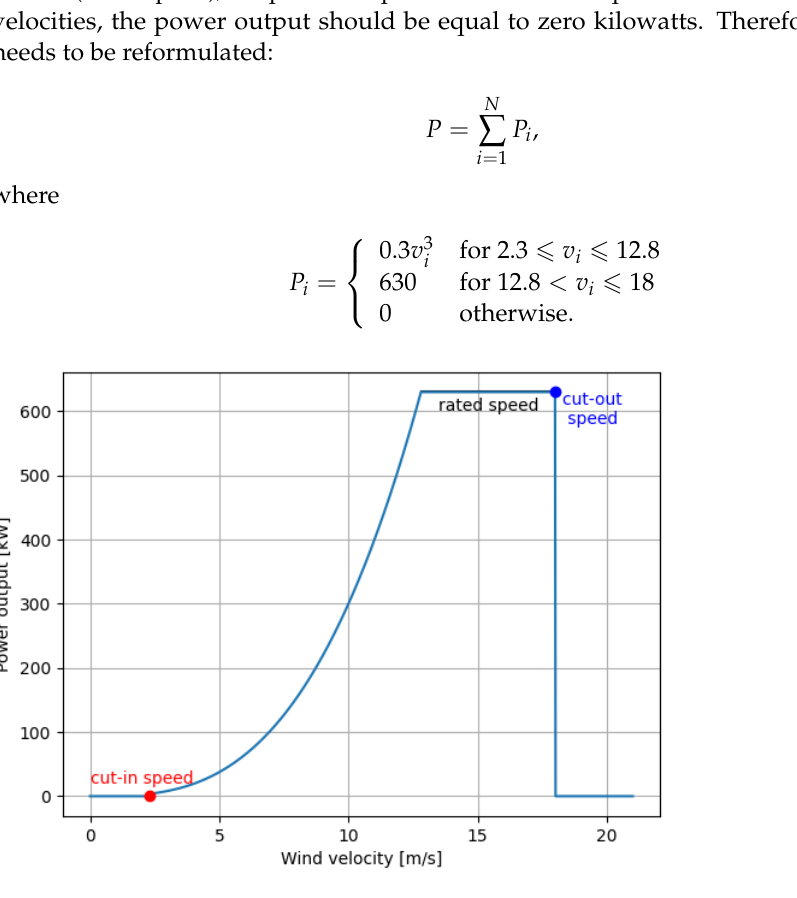
Figure 2. Power curve of a single wind